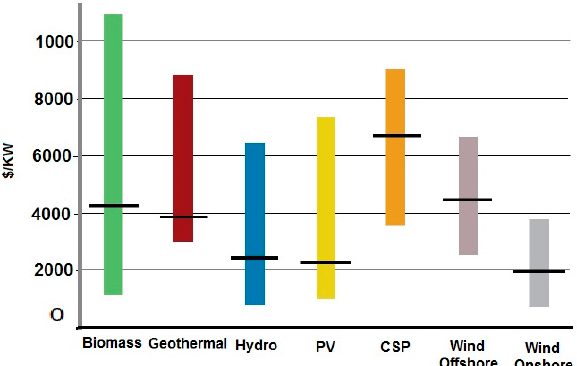
Figure 8. Typical ranges and weighted averages for the total capital costs of renewable power generation technologies (2017) [44].